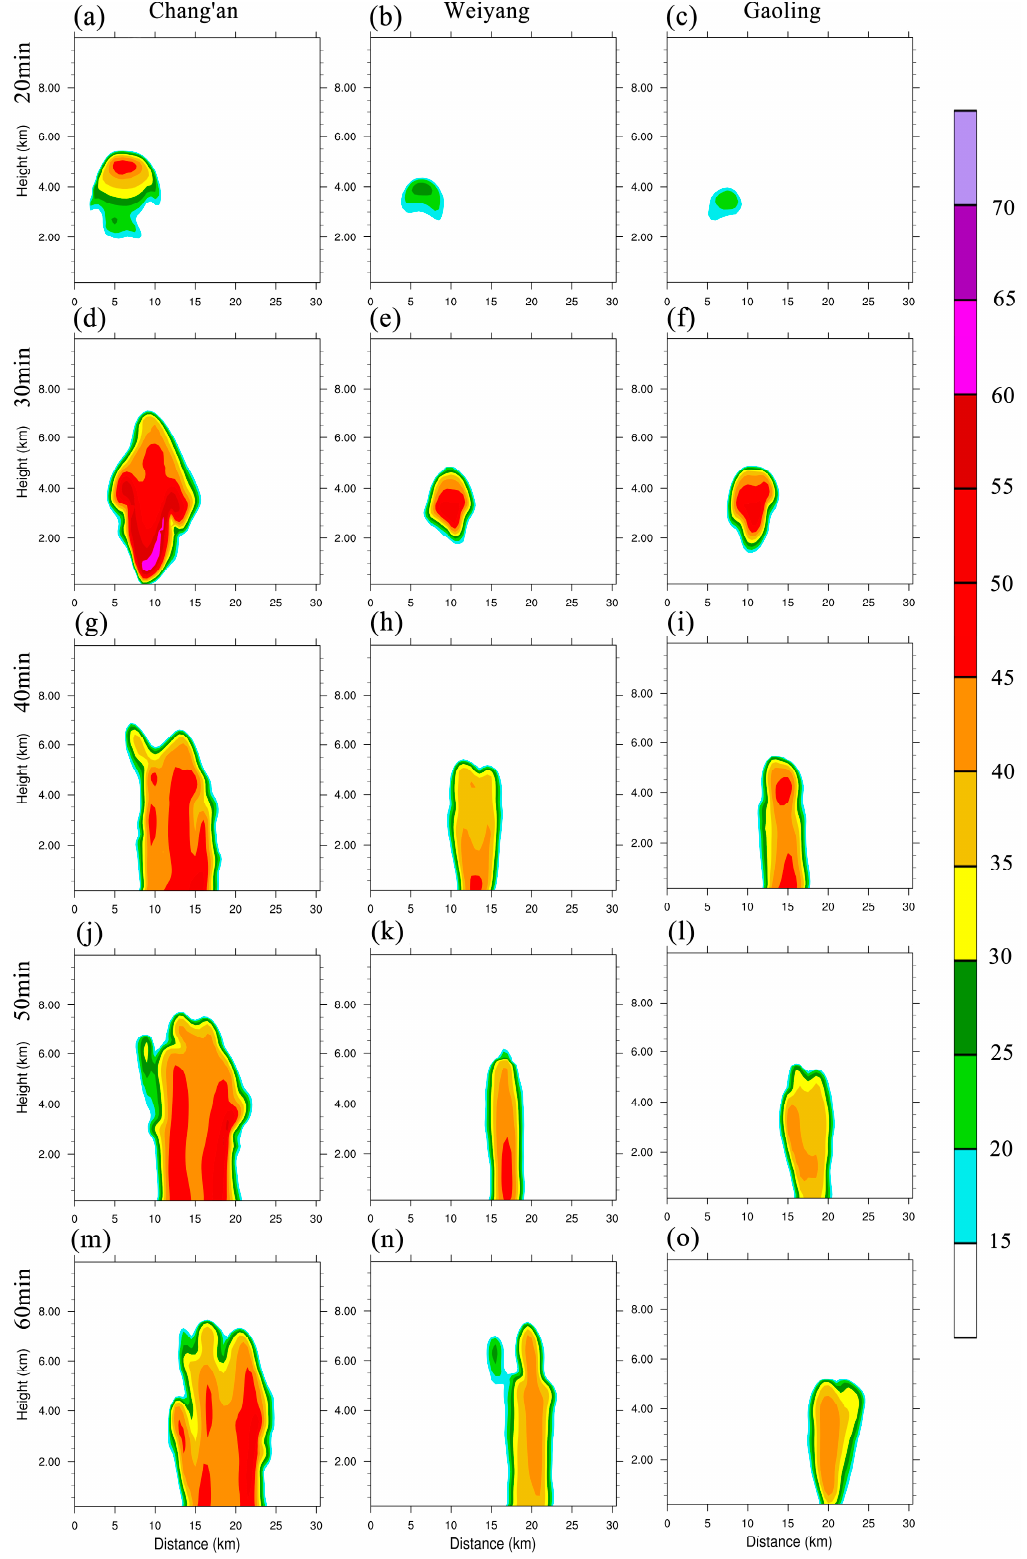
Figure 10. As shown in Figure 9, but for the horizontal profile, which is plotted at the location of the strongest combined radar reflectivity. (where ( a – c ) are 20 min, ( d – f ) are 30 min, ( g – i ) are 40 min, ( j – l ) are 50 min, ( m – o ) are 60 min. ( a , d , g , j , m ) are Chang’an District; ( b , e , h , k , n ) are Weiyang District; ( c , f , i , l , o ) are Gaoling District).